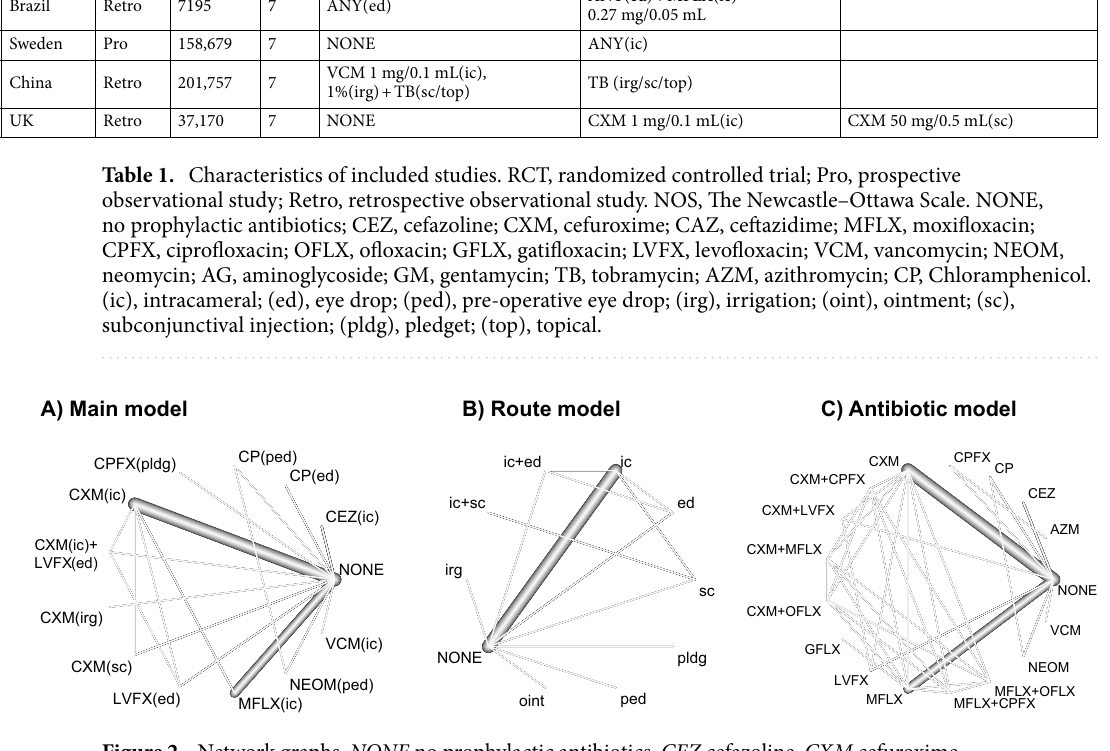
Figure 2. Network graphs. NONE no prophylactic antibiotics, CEZ cefazoline, CXM cefuroxime, CAZ ceftazidime, MFLX moxifloxacin, CPFX ciprofloxacin, OFLX ofloxacin, GFLX gatifloxacin, LVFX levofloxacin, VCM vancomycin, NEOM neomycin, GM gentamycin, TB tobramycin, AZM azithromycin, CP chloramphenicol, VCM vancomycin. ic intracameral, ed eye drop, ped pre-operative eye drop, irg irrigation, sc subconjunctival injection, pldg